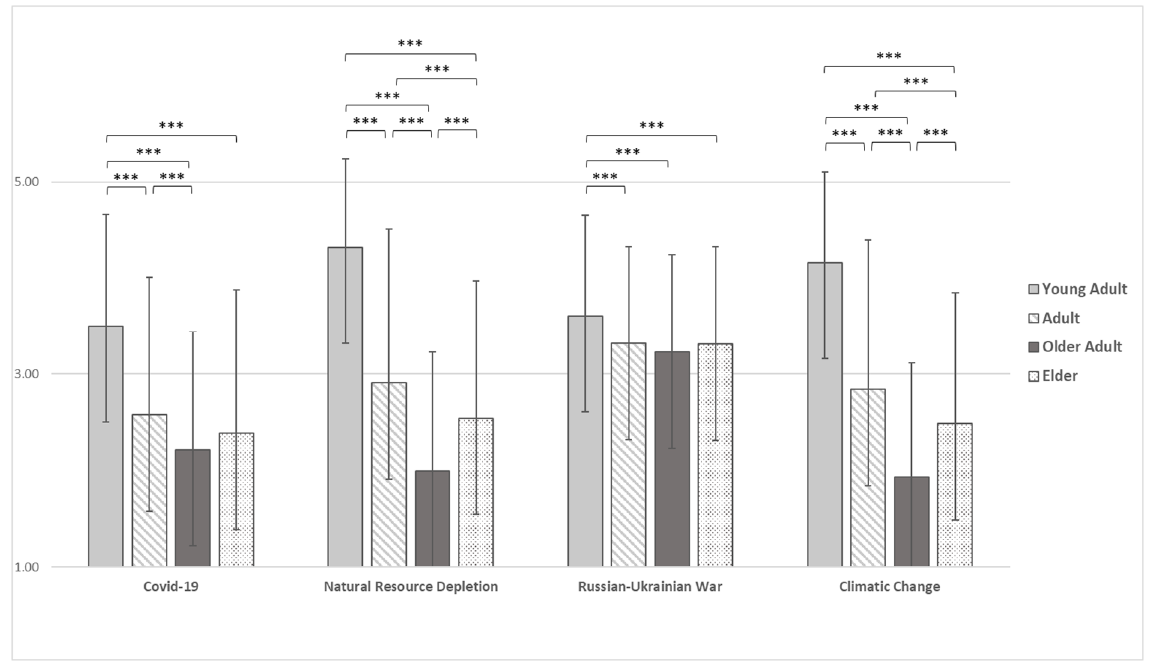
Figure 3. Differences among age groups in COVID-19, Natural Resources Depletion, Russia-Ukraine War, and Climatic Change Willingness to change one’s habits. Note. *** = p < 0.001.